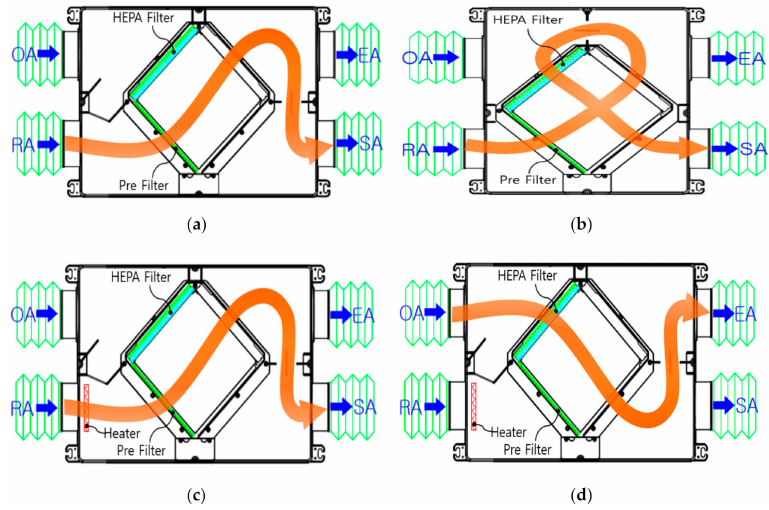
Figure 4. Purge methods: ( a ) conventional; ( b ) circulation; ( c ) heat; ( d ) outward.